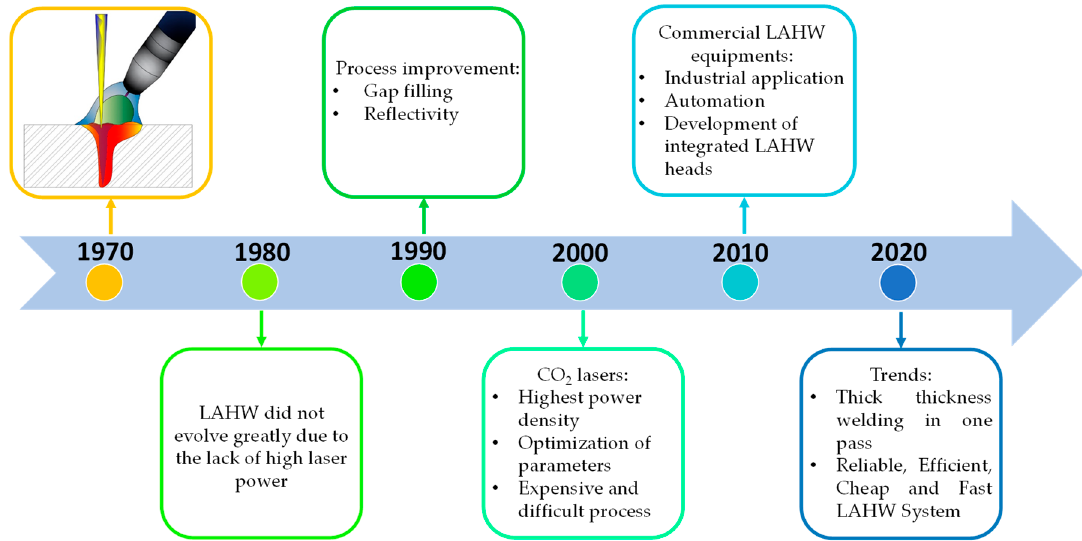
Figure 2. Graphic diagram of the evolution of LAHW.